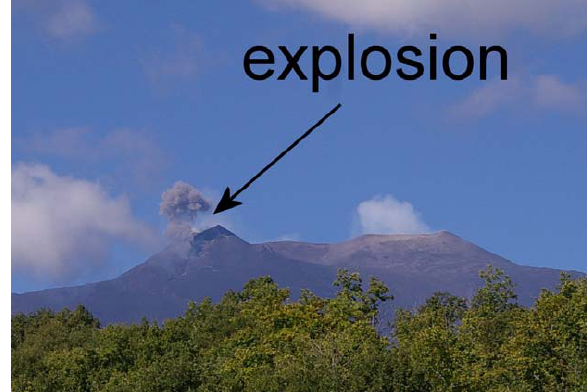
Figure 11. Visible image of Mt. Etna taken on October 15, 2007 from the town of Milo, located approximately 11 km east-south-east of the volcano's summit. In this image, a dark, ash-laden plume is being emitted from the new vent on the eastern flank of the south-east crater. Plumes such as this one were intermittently emitted as a consequence of ongoing explosions at this vent.